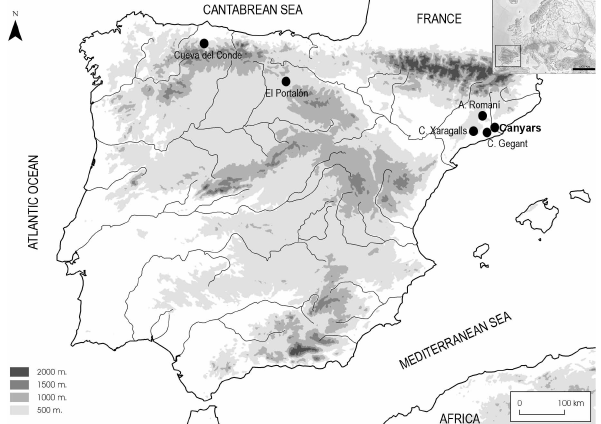
Fig. 1. Location of the sites mentioned in text in the Iberian Penin- sula, including Canyars (Terrasses de la Riera dels Canyars).